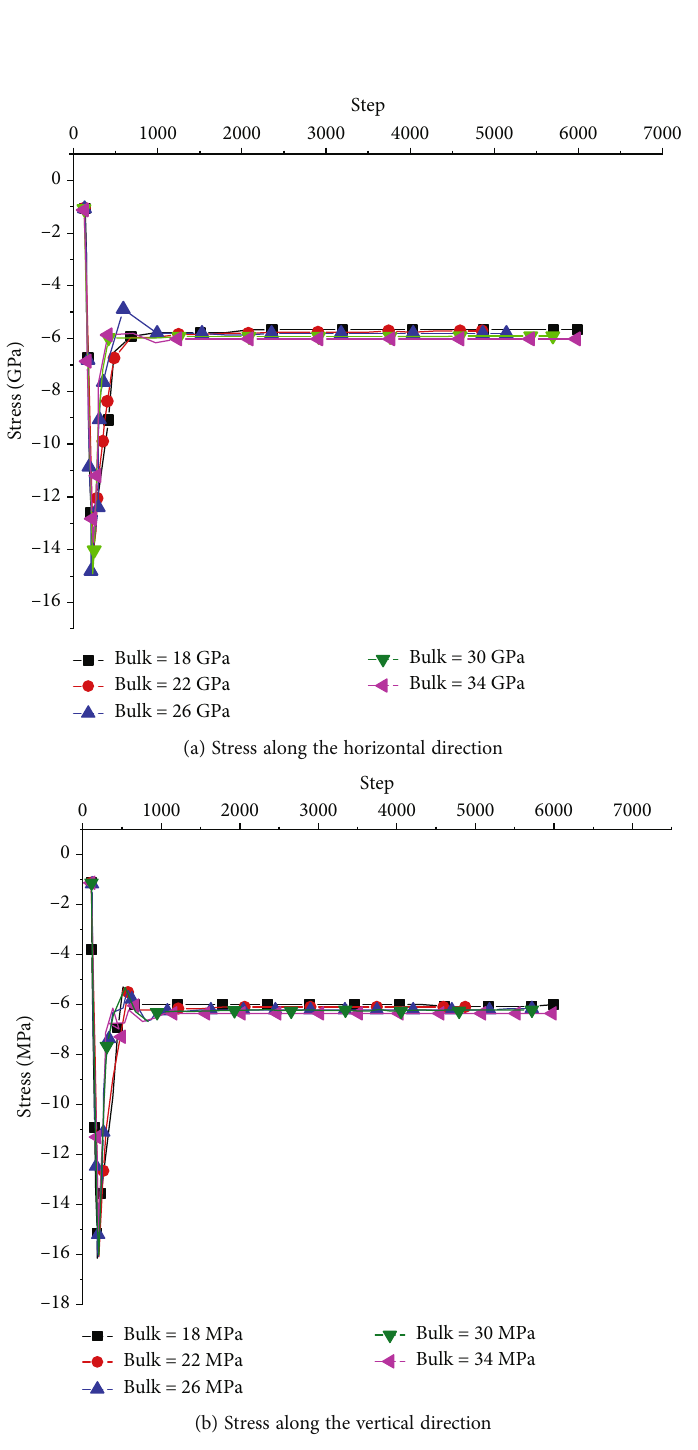
Figure 10: Variation of the stress under the condition that the bulk modulus changes.